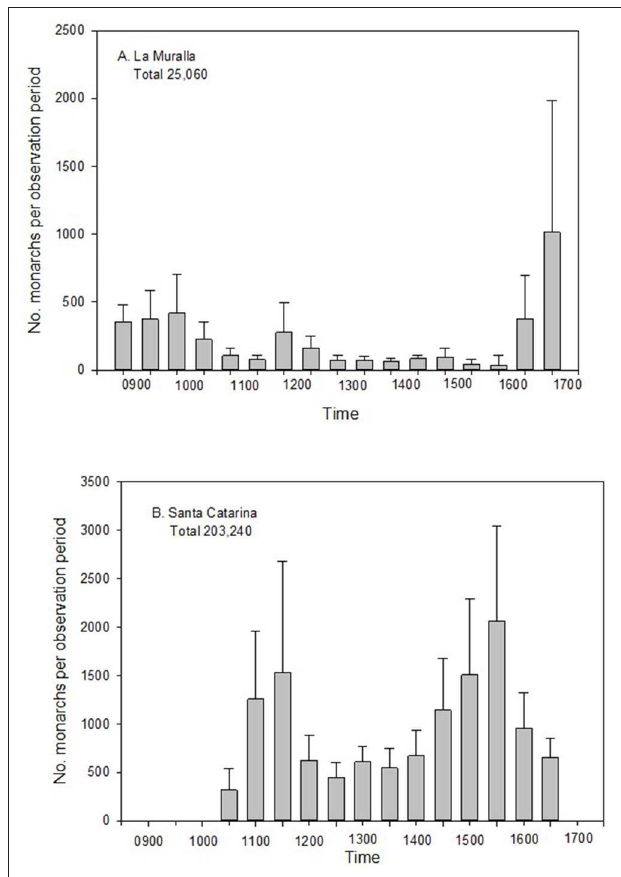
FIGURE 3 | Pattern of diurnal movements of migrating monarchs through (A) La Muralla (15 October − 7 November) and (B) Santa Catarina (24 October − 11